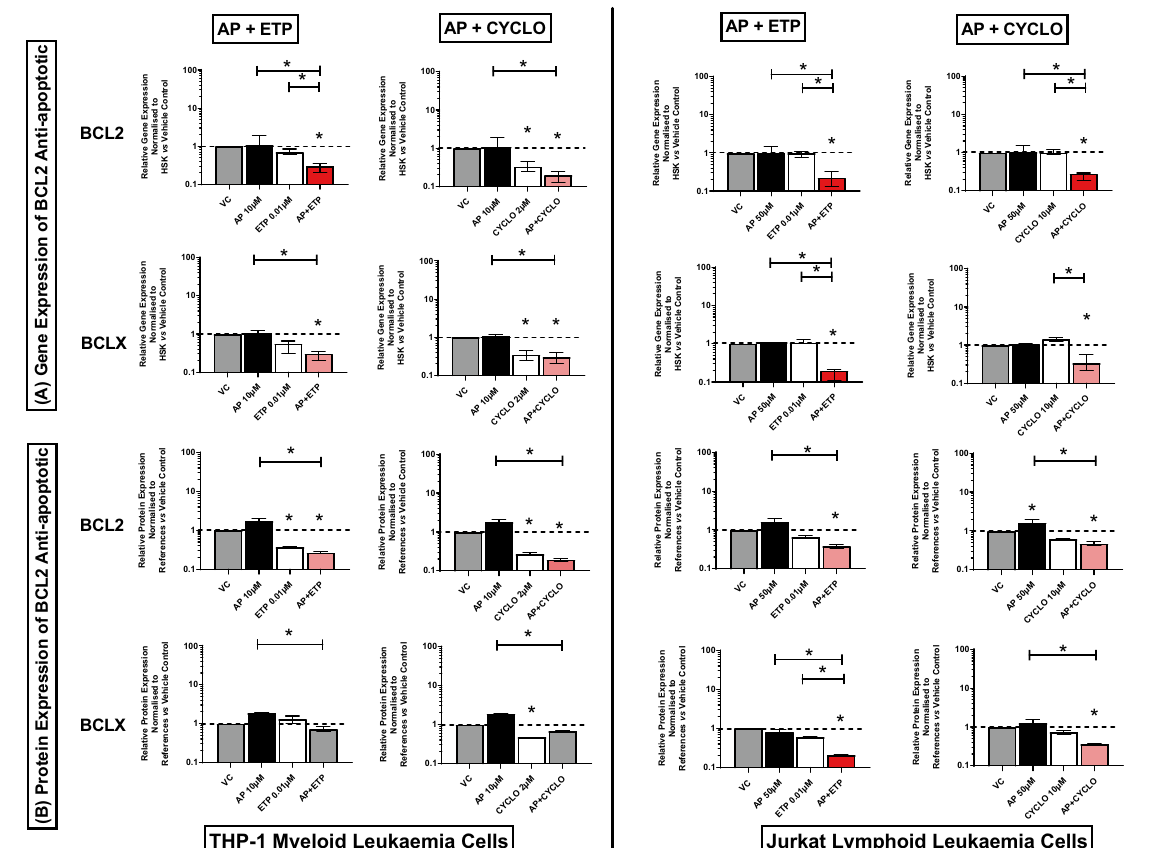
Figure 1. Effects of apigenin (AP) alone and in combination with etoposide (ETP) and cyclophosphamide (CYCLO) on expression of BCL2 and BCLX anti-apoptotic genes ( A ) and proteins ( B ) in acute myeloid (THP- 1) and lymphoid (Jurkat) leukaemia cell lines when treated with their lowest significant doses (LSDs) that induce apoptosis (determined previously in Mahbub et al., 2013, 2015, 2019) for 24 h. Gene and protein data are expressed as medians and ranges. Results were considered statistically significant when P ≤ 0.05 (*). The combination treatment effects and colours were determined based on the statistical analysis Effect of combination treatments on expression of BCL‑2 family pro‑apoptotic genes and pro‑ teins (BAD and BAX). When apigenin was combined with chemotherapy agents in THP-1 cells the induc- tion of BAD which was seen following treatment with apigenin alone, was inhibited in combination treatments (Fig. 2B). However, when Jurkat cells were treated with a combination of apigenin and cyclophosphamide there was a synergistic increase in the expression of BAD gene and protein levels compared to the vehicle controls and drugs alone, (P ≤ 0.05) (Fig. 2A,B) (Supplementary Figs. S1, S2). However, when apigenin was combined with etoposide in Jurkat cells there was a significant increase in BAD gene expression when compared to the vehicle controls and etoposide alone, but a synergistic response was not seen (P ≤ 0.05) (Fig. 2A); and protein expression was unchanged (Fig. 2A,B) (Supplementary Figs. S1, S2). Interestingly, all investigated combination treatments caused a synergistic increase in the expression of BAX gene and protein levels in both THP-1 and Jurkat cells when compared to the vehicle controls and drugs alone, (P ≤ 0.05) (Fig. 2A,B) (Supplementary Figs. S1, S2). Effect of combination treatments on expression of mitochondrial genes and proteins (CYT c , SMAC/DIABLO, HTRA2/OMI). In both acute myeloid and lymphoid leukaemia cells (THP-1 and Jurkat), all the investigated combination treatments synergistically increased the gene and protein expression of CYT c (Fig. 3A,B) (Supplementary Figs. S1, S2), and SMAC/DIABLO (Fig. 4A,B) (Supplementary Figs. S1, S2), when compared to the vehicle controls and drugs alone, (P ≤ 0.05). Similarly, there was a synergistic increase in the expression of HTRA2/OMI gene and protein in Jurkat lymphoid leukaemia cells when treated with all the com- bination treatments (P ≤ 0.05) (Fig. 4A,B). However, in THP-1 myeloid leukaemia cells, there was a significant increase in the expression of HTRA2/OMI gene and protein when compared to the vehicle controls and the chemotherapy drugs alone (P ≤ 0.05), but a synergistic response was not observed (Fig. 4A,B) (Supplementary Figs. S1, S2).